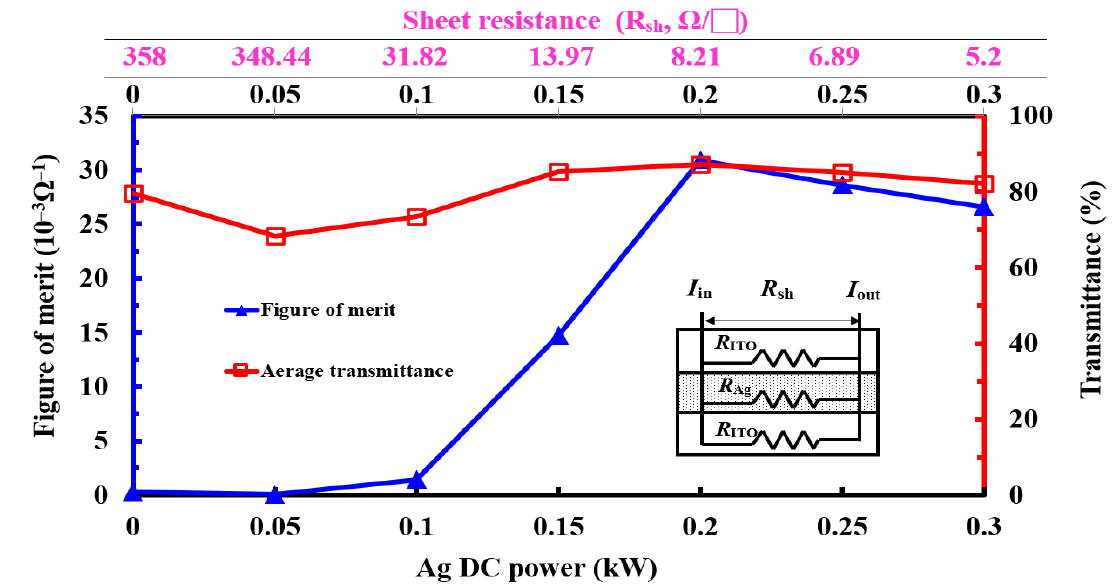
Figure 6. Figure of merit ( φ TC ) and average optical transmittance for the ITO/nano-Ag/ITO multi- layer films as a function of the Ag DC power ranging from 0 to 0.3 kW. The parallel circuit model of ITO/nano-Ag/ITO multilayers is at inset, and the sheet resistance values (R sh ) corresponding to DC powers are also set at the top of the graph.